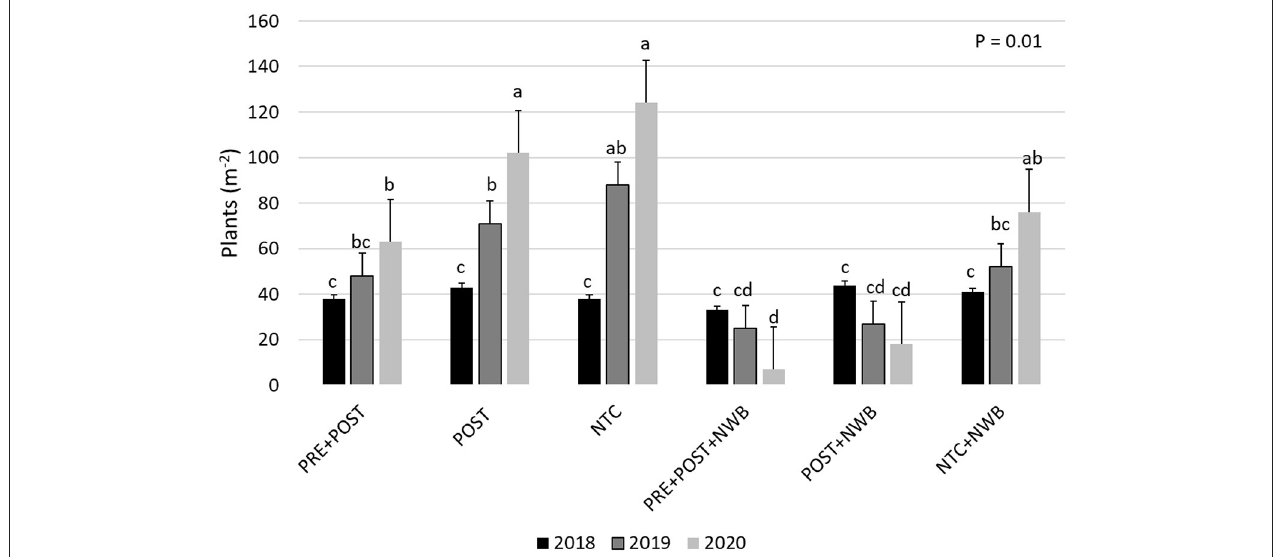
FIGURE 3 | Final weed density for Amaranthus palmeri at soybean harvest from 2018 to 2020 for each herbicide treatment with and without narrow-windrow burning. Means followed by the same letter are not statistically different according to Fisher’s protected LSD ( α = 0.05).